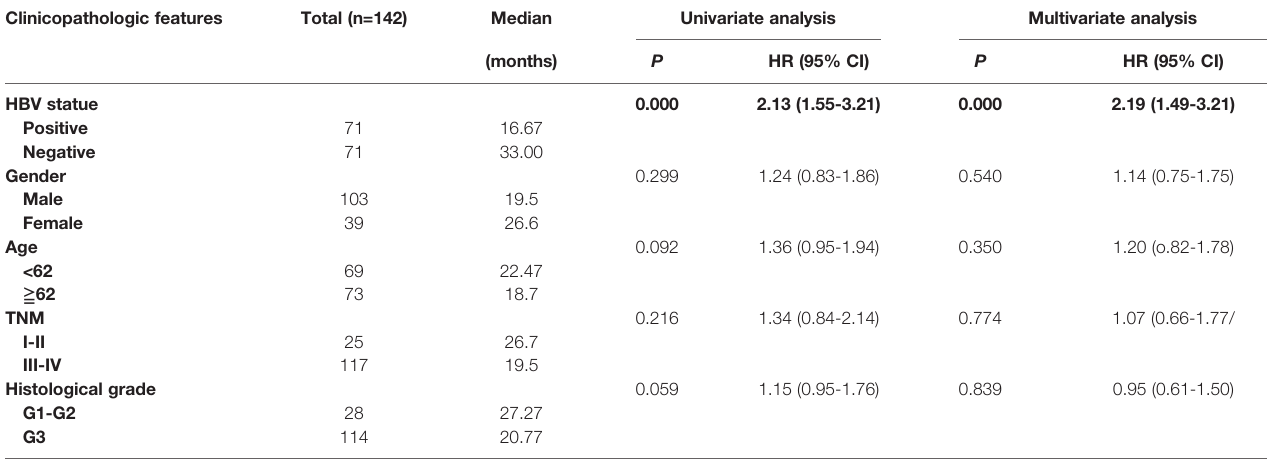
DFS, disease free survival; CI, con fi dence interval; HR, hazard ratios; HBV positive ,positive for HBsAg or anti-HBs, anti-HBe, and anti-HBc; HBV negative, negative for HBsAg, HBeAg, anti-HBe, anti-HBs, and anti-HBc; TNM, tumor, lymph node,